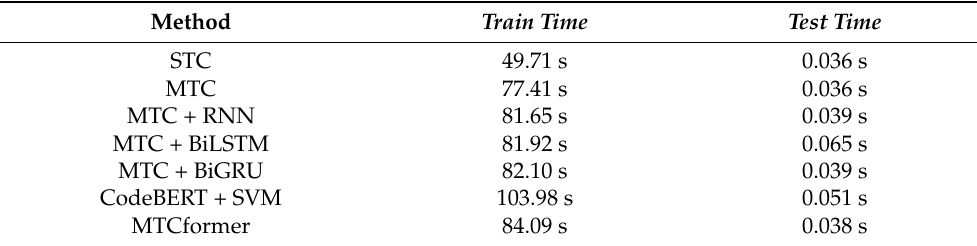
Table 5. The efficiency of different methods.